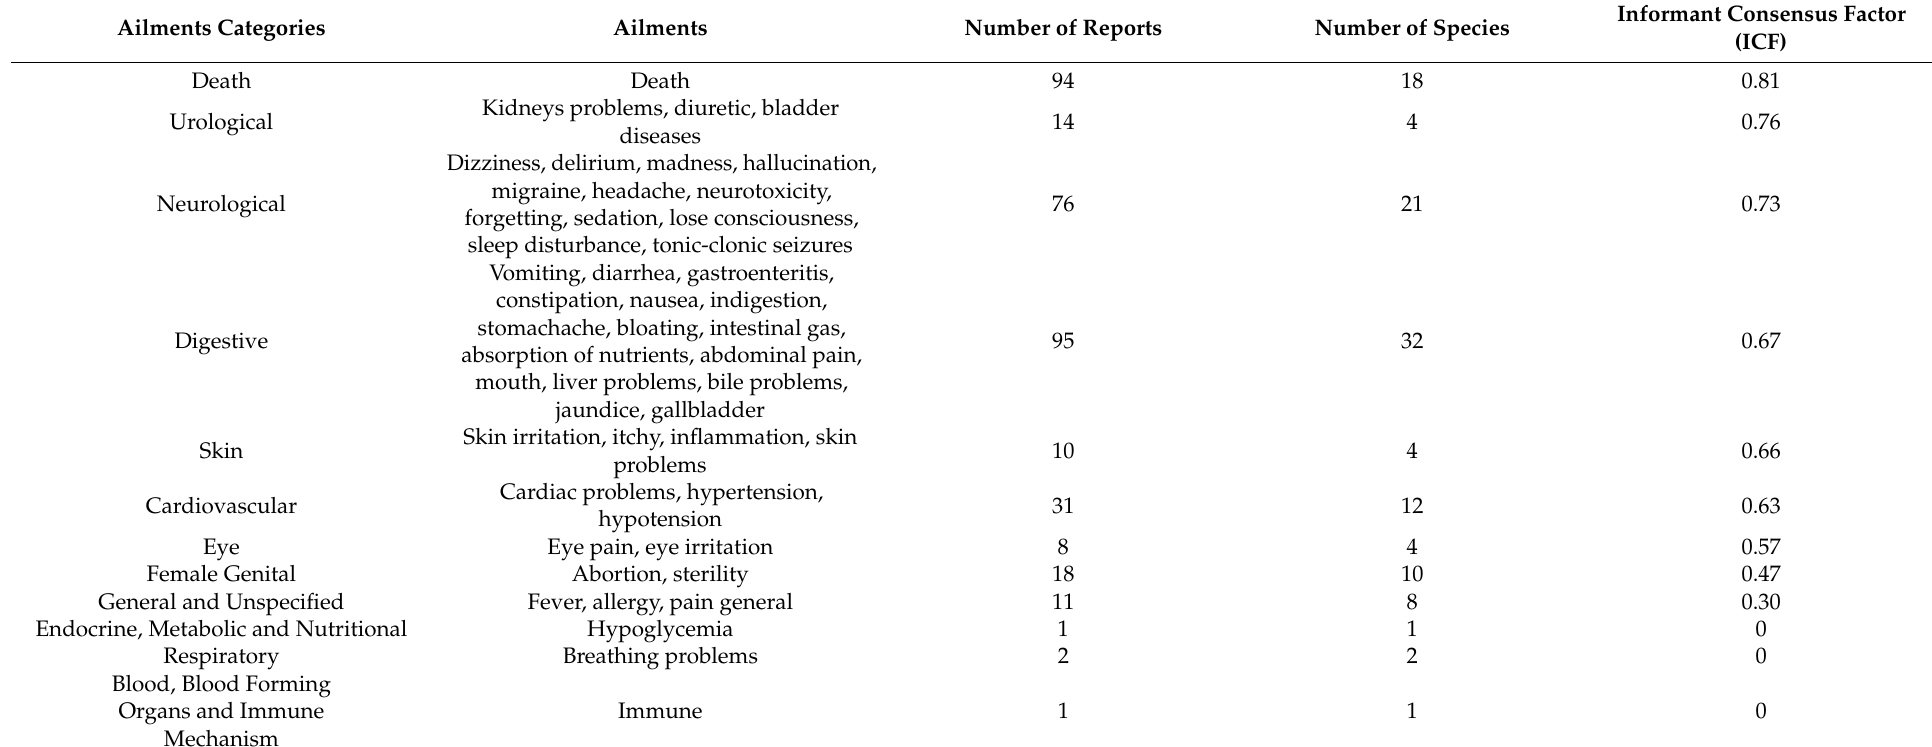
Table 3. Category of illness and their informant consensus factor